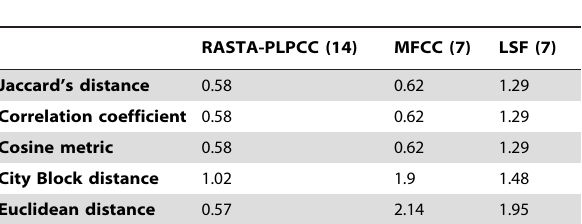
Table 3. The variance of the ranks for all correct matches within the first three ranks by the five similarity indices for the three spectral feature extraction